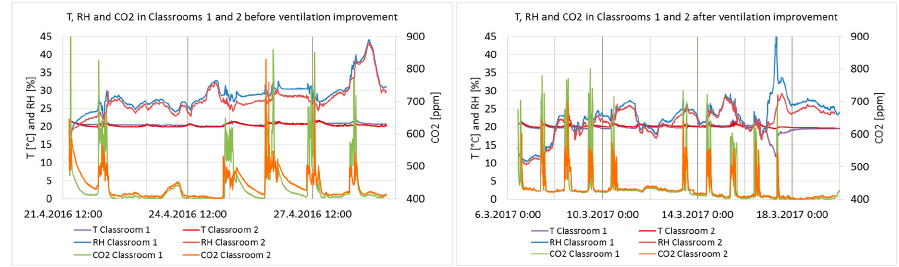
Table 2. Minimum, maximum and average values of RH, T, and CO 2 in Classrooms 1 and 2, during 8